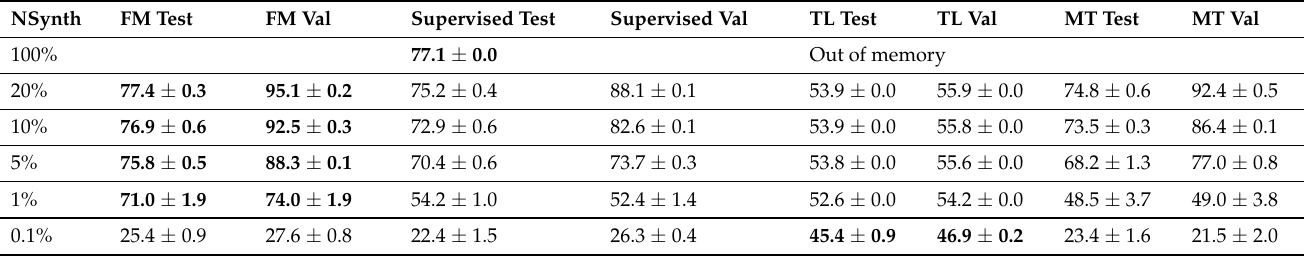
Table A3. Detailed results for NSynth dataset from Figure 6 with file-wise accuracy and standard deviation on test set (test) and unlabeled training set